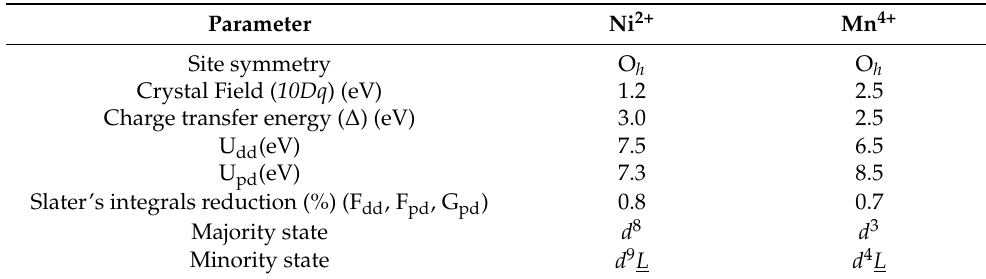
Table 2. Best-fit parameters used for the multiplet calculations-based simulations of the experimental Ni and Mn L 2,3 - edge XAS and XMCD spectra of PNMO